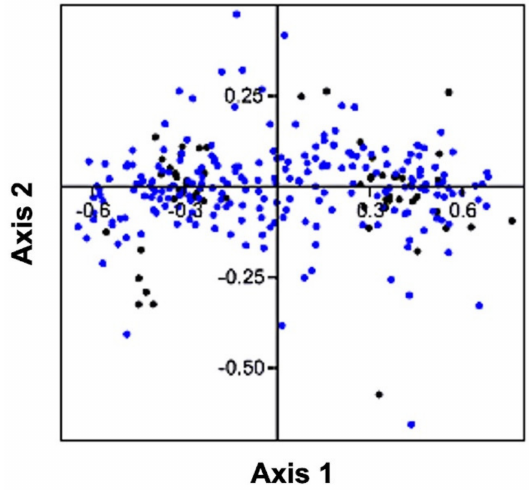
Figure 5. Correspondence analysis (CoA) of human autophagy genes. The CoA is represented by blue and black colored dots designating the genes and their codons, respectively.